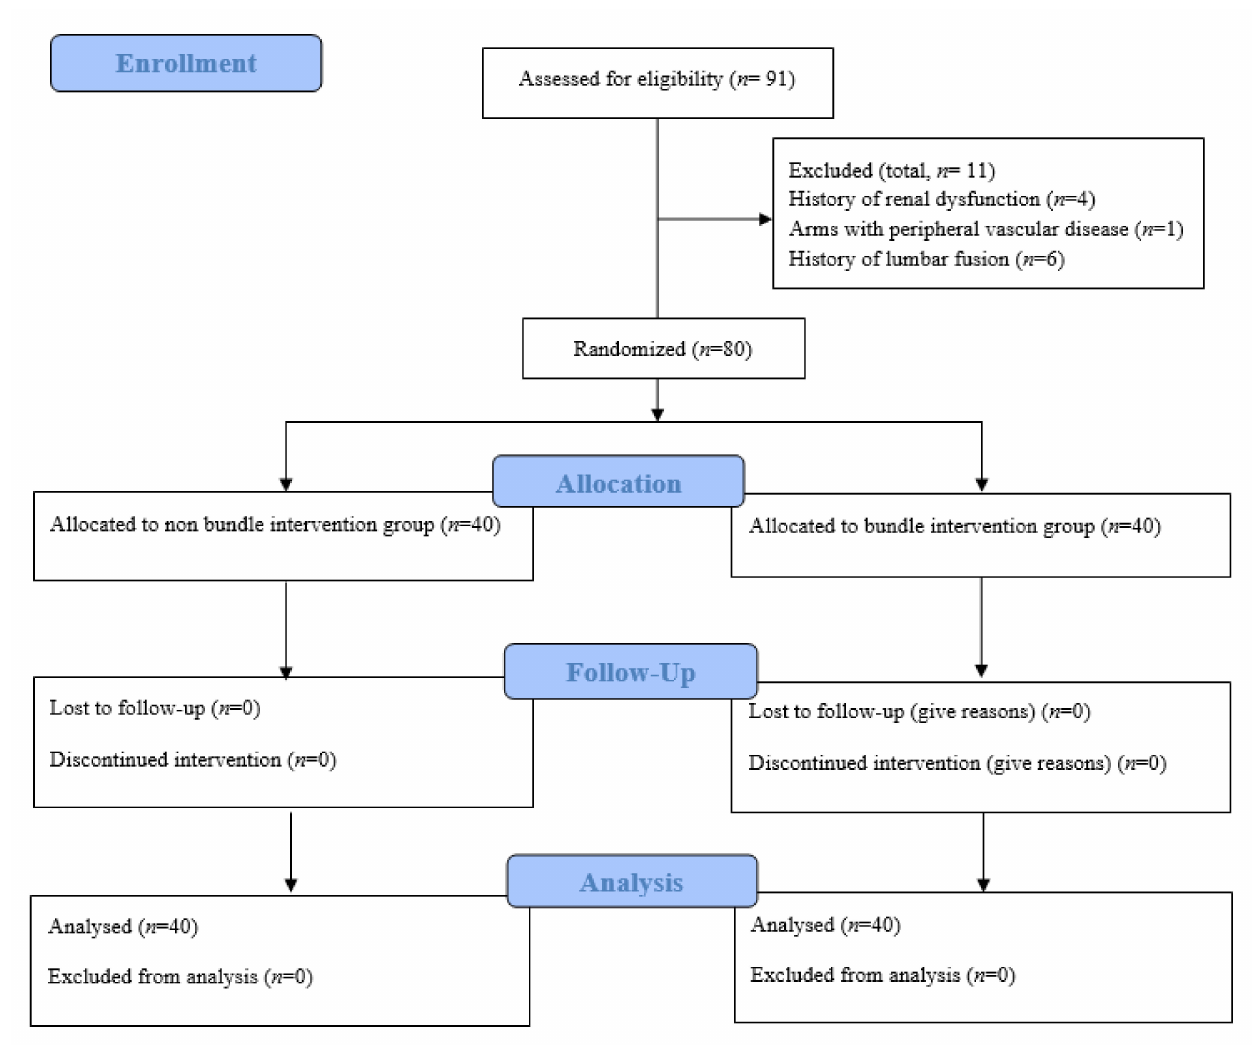
Figure 1. CONSORT flow